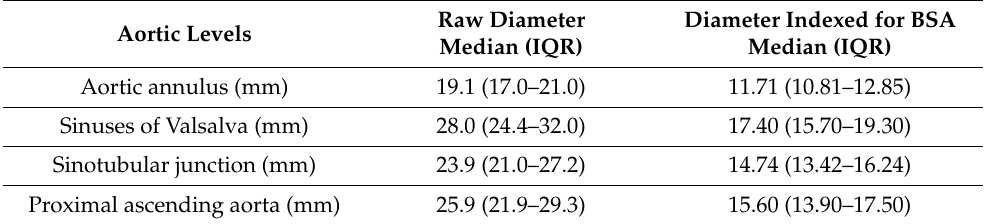
Table 2. Aortic size at aortic annulus, sinuses of Valsalva, sinotubular junction and proximal ascend- ing aorta level (raw diameter and diameter indexed for BSA) of the 1112 healthy